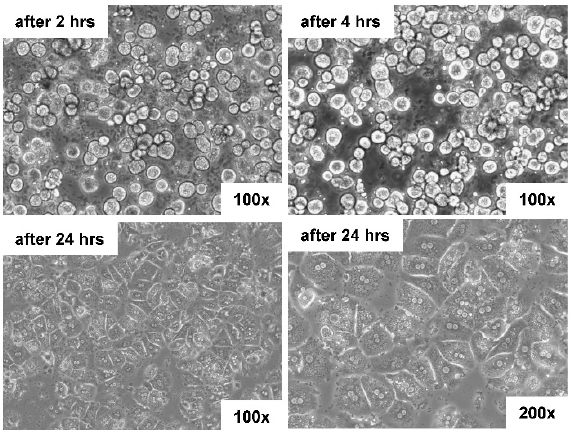
Figure 4. Light microscopic appearance of hepatocytes isolated with the gentleMACS Perfusion Technology. Primary hepatocytes were isolated from a 3-month-old male mouse and seeded in HepatoZYME-SFM medium (#17705021, ThermoFisher, Dreieich, Germany). The medium was changed to Dulbecco’s Modified Eagle’s Medium containing 10% fetal bovine serum, 2 mM L-glutamine, 100 IU/mL penicillin, and 100 µg/mL streptomycin (all from ThermoFisher) two hours after initial plating. Pictures were taken at indicated times and magnifications.